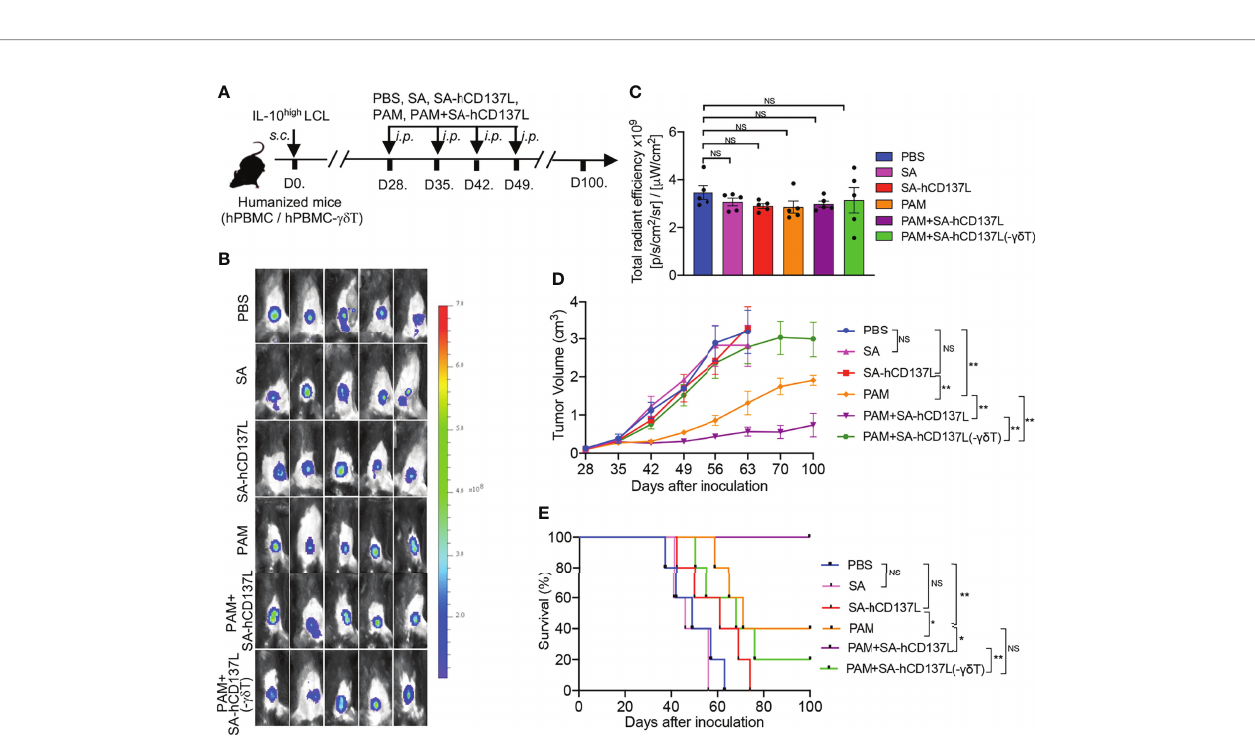
FIGURE 5 | CD137 costimulation improved the therapeutic effect of PAM in controlling EBV-induced lymphoma with IL-10 high TME in humanized mice. (A) The evaluation protocol of the synergistic therapeutic effect of PAM and SA-hCD137L on EBV-induced lymphoma in humanized mice ( fi ve mice per group). (B, C) Whole- body fl uorescence images (B) and total radiant ef fi ciency (C) of mice before treatment with PAM, SA-hCD137, SA and PBS. (D, E) The tumor volume (D) and mouse survival (E) were determined at the indicated time. The tumor volume was analyzed by two-way ANOVA test, and mice survival was analyzed by Kaplan- Meier log-rank test. Data are representative for three independent experiments. *p < 0.05; **p < 0.01; ns, no signi fi cant difference.